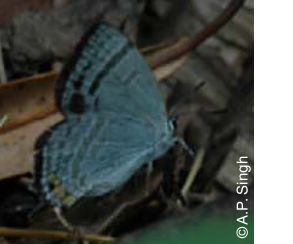
Image 12. Powdery Green Sapphire, Heliophorus tamu - females